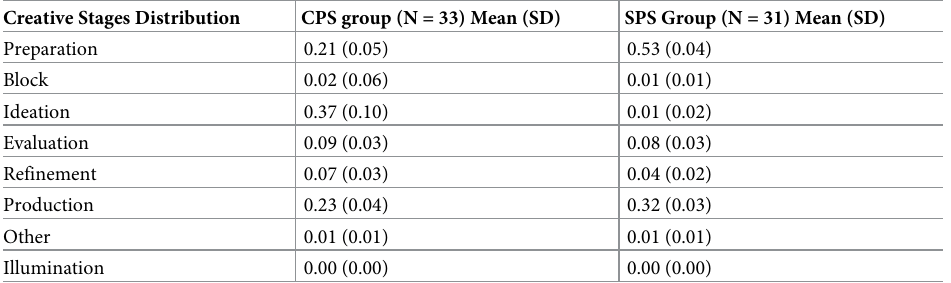
Table 3. Mean values of the stationary state distribution of the creative stages between the CPS and SPS groups.